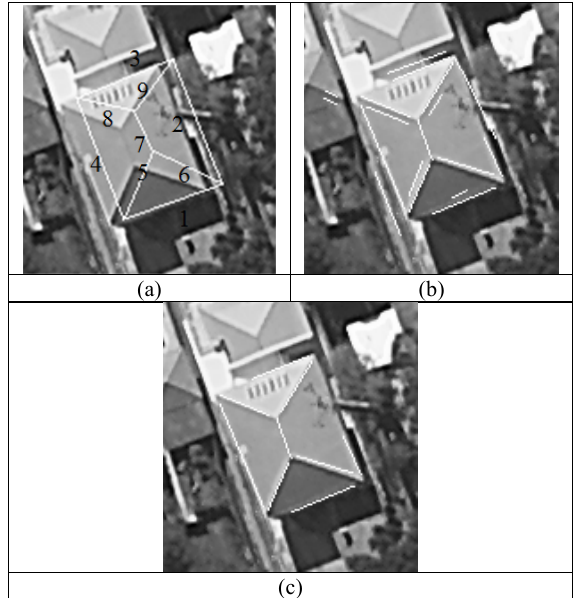
Figure 3. Test 2. (a) Projected roof; (b) extracted lines of the image; and (c) results of the energy function